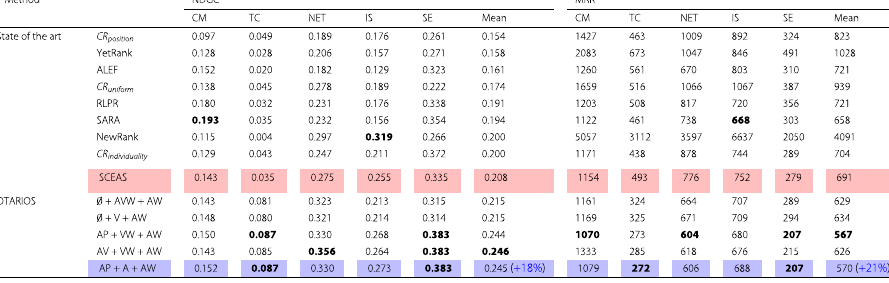
The value of each cell is the metric’s mean value for that network (e.g., the mean NDCG and MRR of AP+A+AW for network NET is highlighted in Table 6). In bold we highlight the highest score for each metric. The best STOA method (i.e., SCEAS) is colored in red and the best OTARIOS variant is colored in blue. Inside parentheses we show the gain of OTARIOS versus SCEAS, i.e., G NDGC and G MRR ,